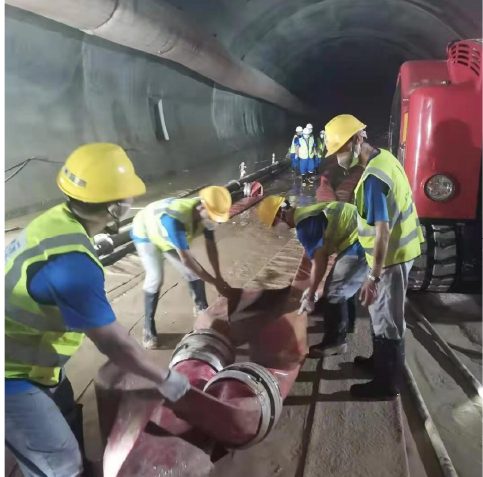
Figure 3. Rescue workers are laying out pumping equipment (Picture from: https://www.guancha.cn/politics/2021_07_17_598831_s.shtml, accessed on 18 January 2022).